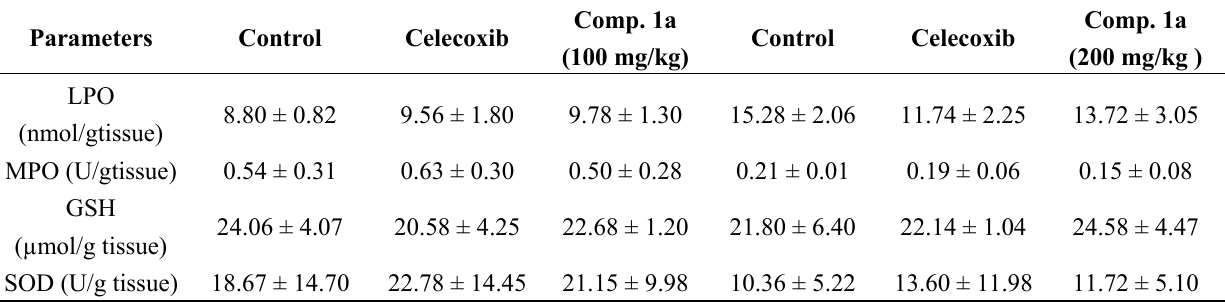
Table 3. Oxidative stress parameters in liver.